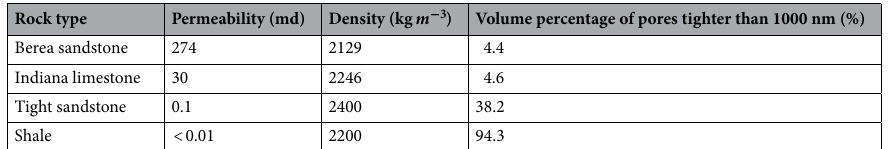
Table 2. Permeability, density, and pore volume percentages in various tested reservoir rocks (Al-Kindi and Babadagli 6 ).